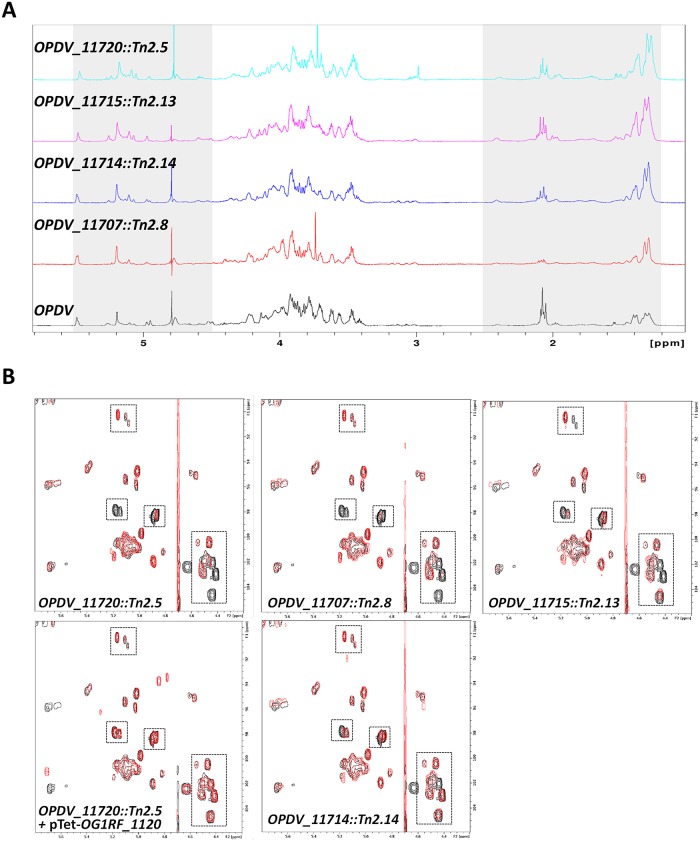
Structural analysis of purified EPA polysaccharides.A. 1D proton spectra of the EPA polysaccharides extracted from strains OPDV, OPDV_11720::Tn2.5, OPDV_11715::Tn2.13, OPDV_11714::Tn2.14 or OPDV_11707::Tn2.8. The grey boxes indicate anomeric (4.5–5.5 ppm) and methyl protons (1.2–2.5 ppm). B. 2D 1H-13C HSQC spectra of EPA polysaccharides. The region corresponding to anomeric protons (4.2–5.5 ppm) and anomeric carbons (90–105 ppm) is shown. OPDV signals are in black, mutant signals in red. Boxes show signals with a lower intensity or a shift in the mutant EPA samples. Close-up views of the boxed regions are shown in S4 Fig.